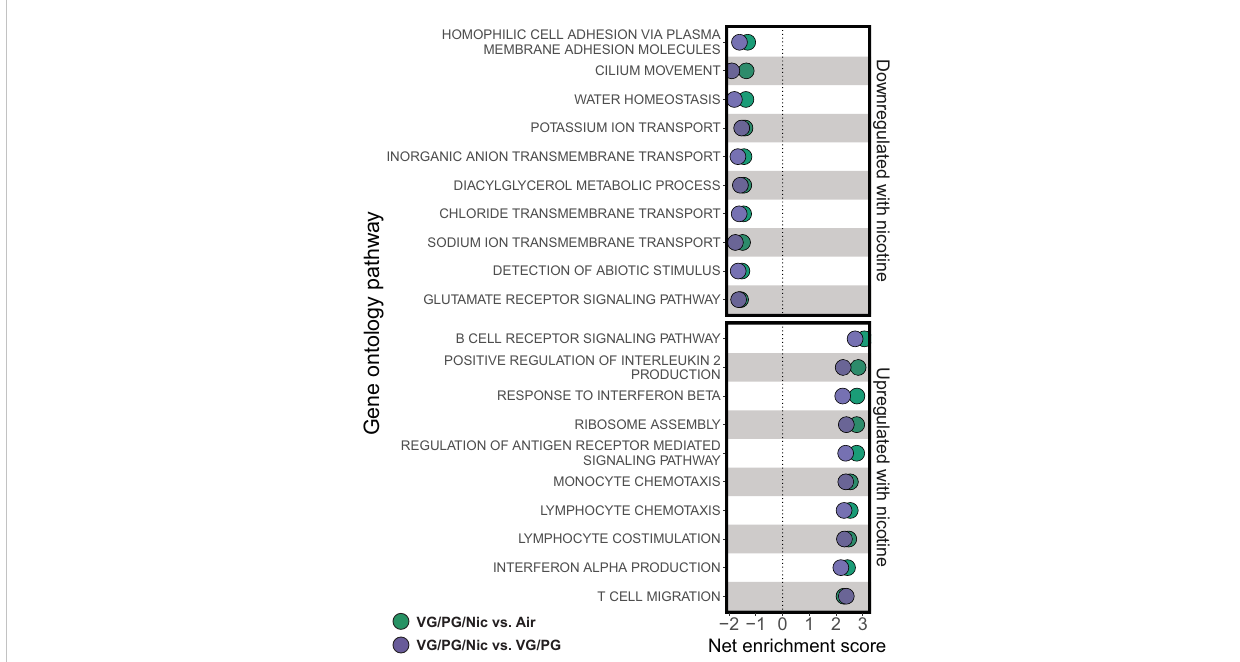
FIGURE 7 Aerosolized nicotine downregulates pathways for ciliary defense mechanisms and ion transport, and upregulates immune activation during in fl uenza infection. Gene set enrichment analysis based on differentially expressed genes for the top downregulated and upregulated pathways in the lungs of in fl uenza-infected mice exposed to nicotine-containing e-cigarette aerosol (VG/PG/Nic) compared to those exposed to nicotine-free aerosol (VG/ PG, purple) or to air (green). Aerosolized nicotine exposure caused a downregulation of pathways associated with ciliary functions, ion transport, and water balance and an upregulation of innate and adaptive immune signaling seven days after in fl uenza